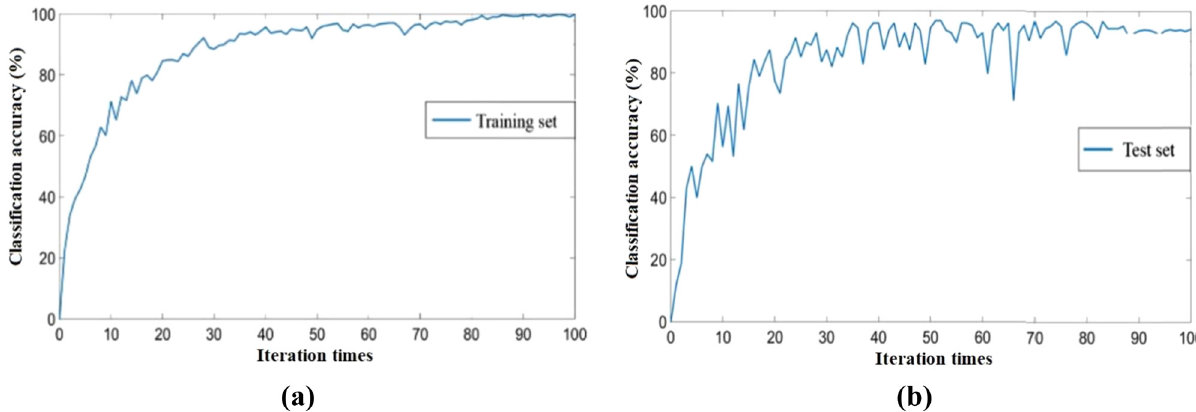
Figure 8: ( a ) Classi fi cation analysis of BP neural network on training set; ( b ) classi fi cation analysis of BP neural network on the test